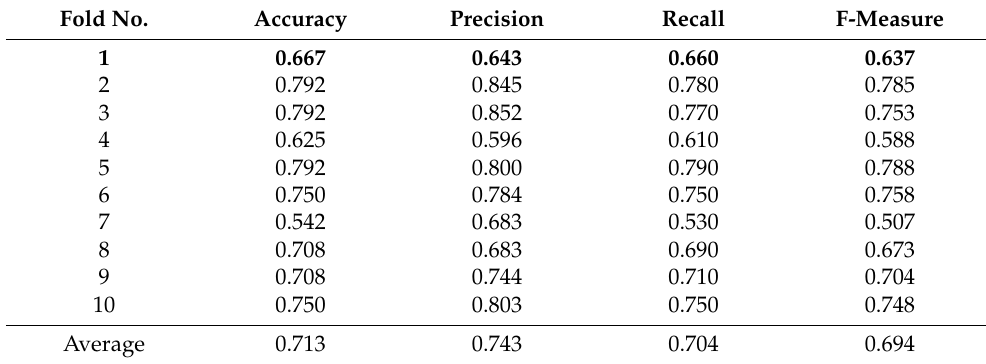
Table 6. Accuracy, precision, recall, and F-measure of proposal method (mixed-gender). Fold No.